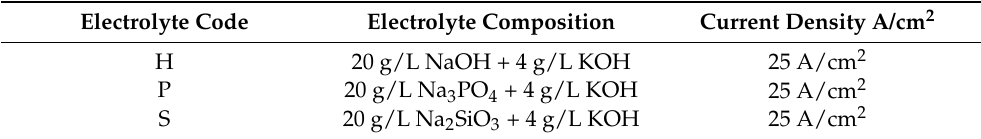
Table 2. Electrolyte composition for the PEO